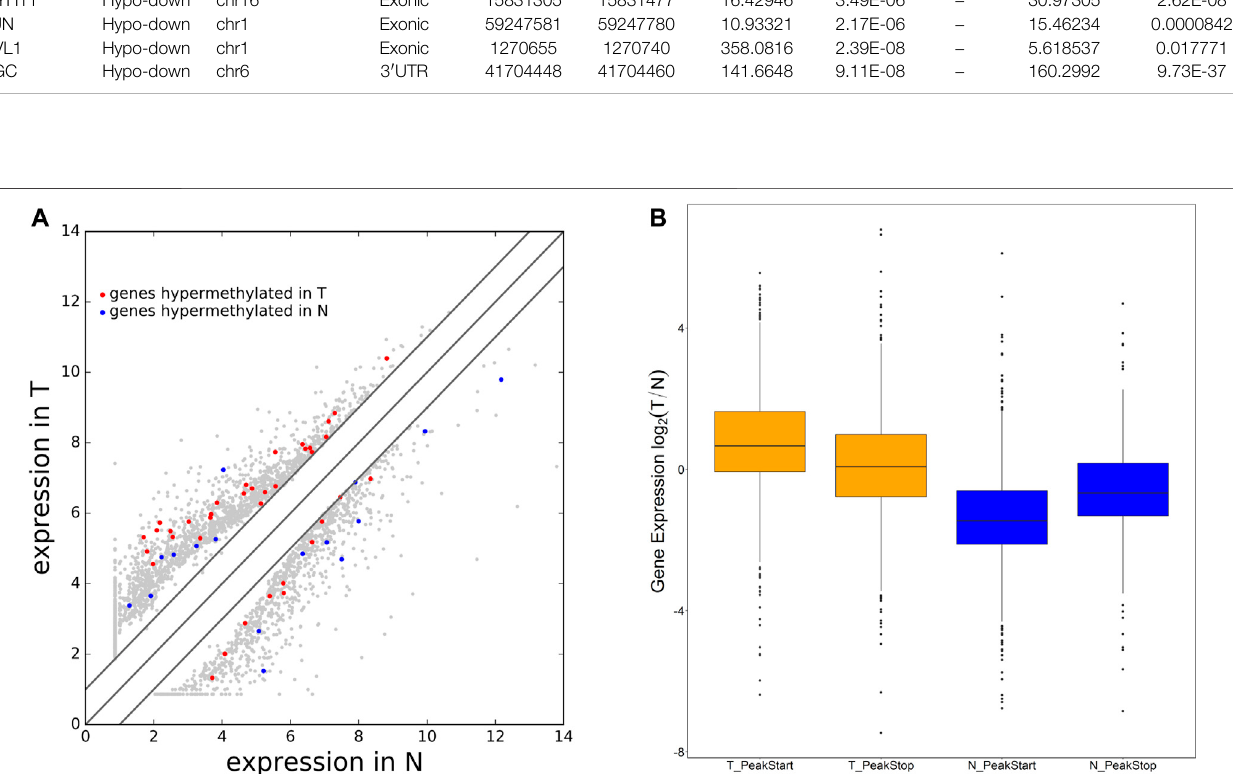
Frontiers in Genetics |